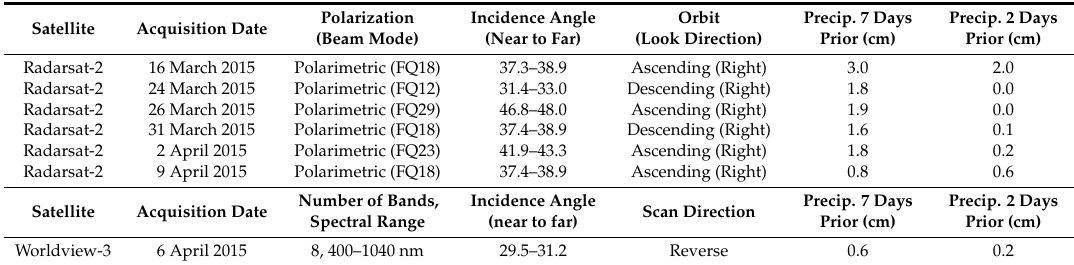
Table 2. Characteristics and date of collection for the Radarsat-2 (Single Look Complex (SLC), 4.7 to 4.9 m spatial resolution) and Worldview-3 imagery (2 m spatial resolution) utilized in the analysis. Precipitation is averaged from four nearby weather